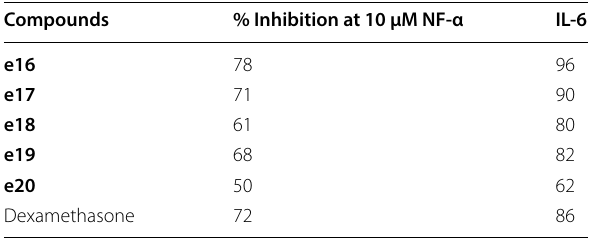
Table 41 Anti-inflammatory activity of novel